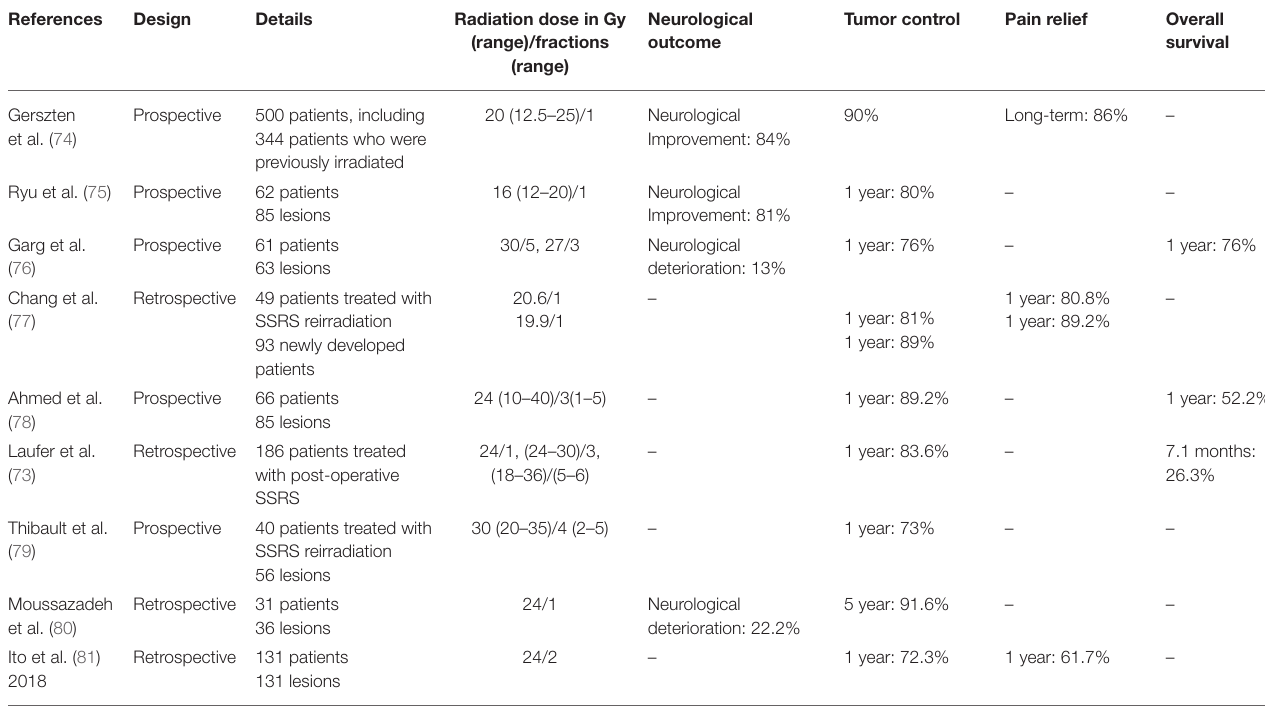
TABLE 1 | Selected studies of spine stereotactic radiosurgery in treatment of metastatic spinal